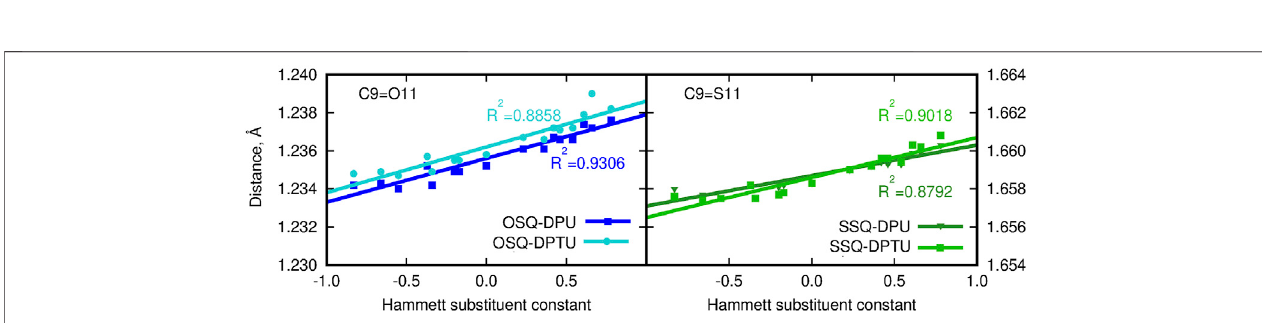
FIGURE 3| C9-O/S11 bond length for squaraine derivatives (atom numbering in Figure 1B ; blue lines/points denote the oxygen-containing squarainecomplexes and green lines/points, its thioderivative, while darker lines are used for urea and lighter for thiourea).